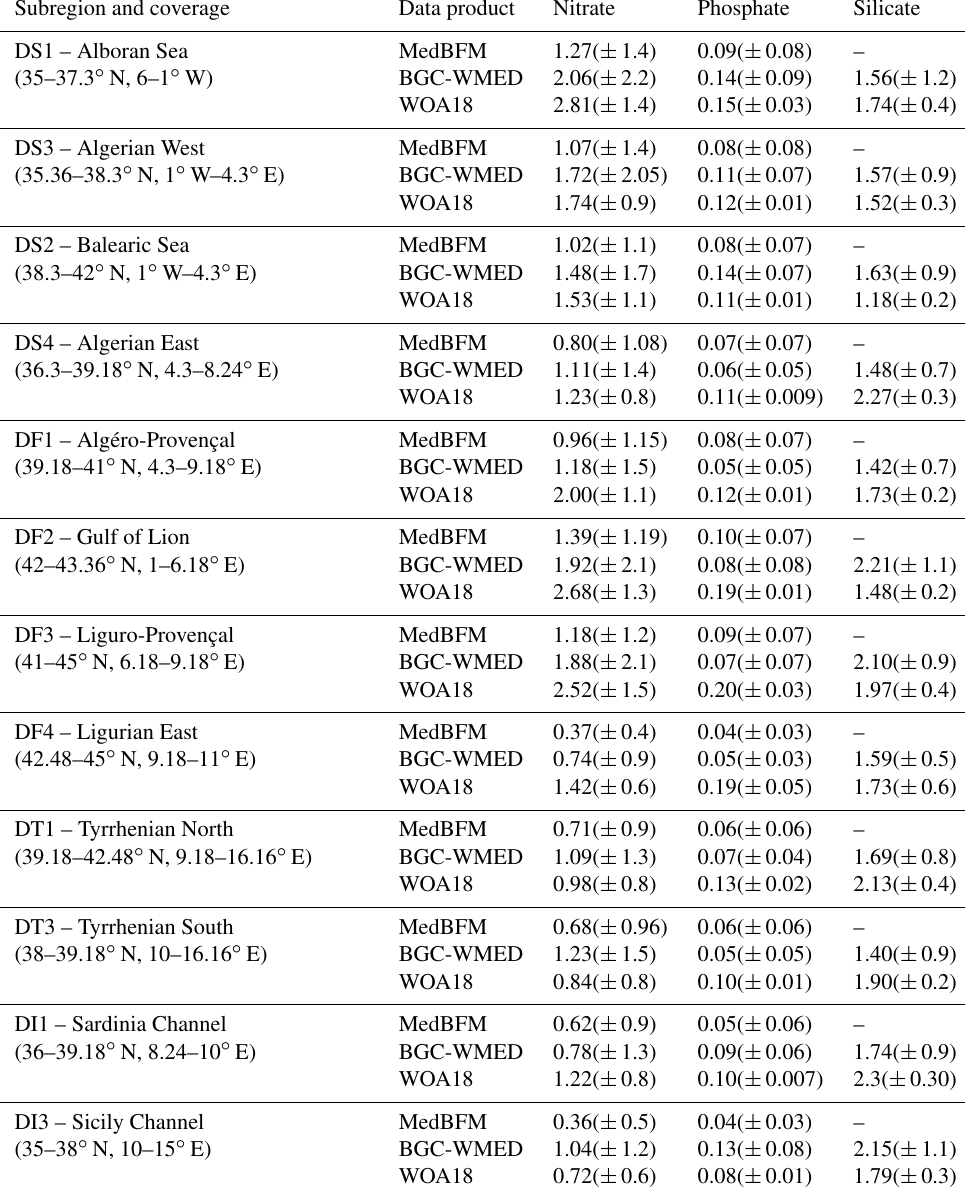
Table 4. Nutrient average concentrations and standard deviation in the upper 150m. All products were interpolated at a 1 ◦ grid resolution (see Fig. S2 in the Supplement; Belgacem et al.,